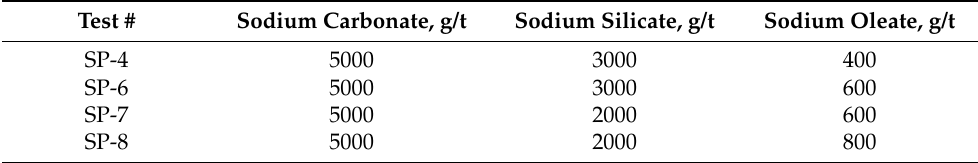
Table 4. The flotation conditions of phosphate rougher flotation of skarn phosphate.